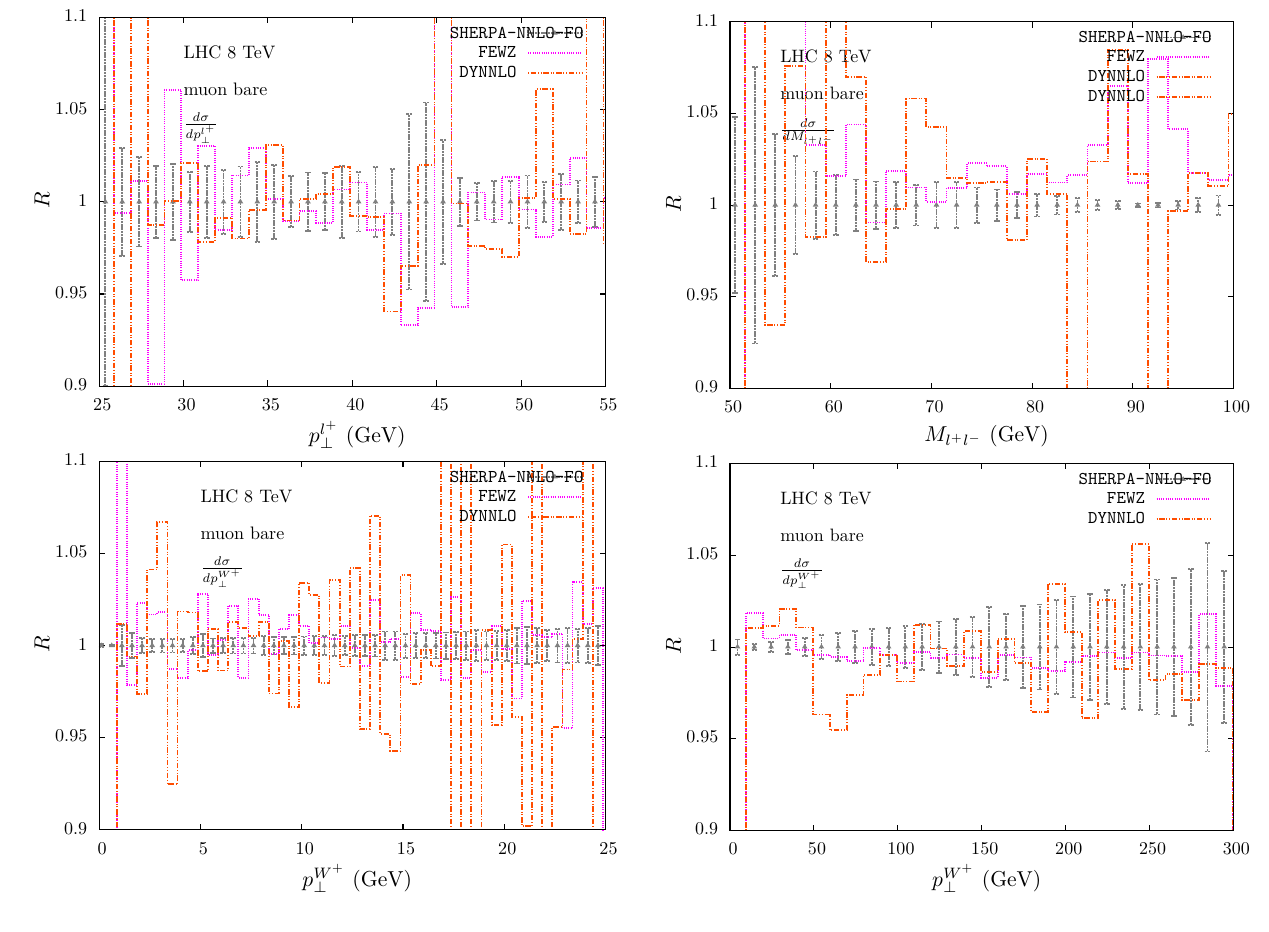
pair invariant mass ( upper right ) and lepton-pair transverse momen- tum ( lower plots ) distributions, obtained in the benchmark setup with ATLAS/CMS cuts at the 8 TeV